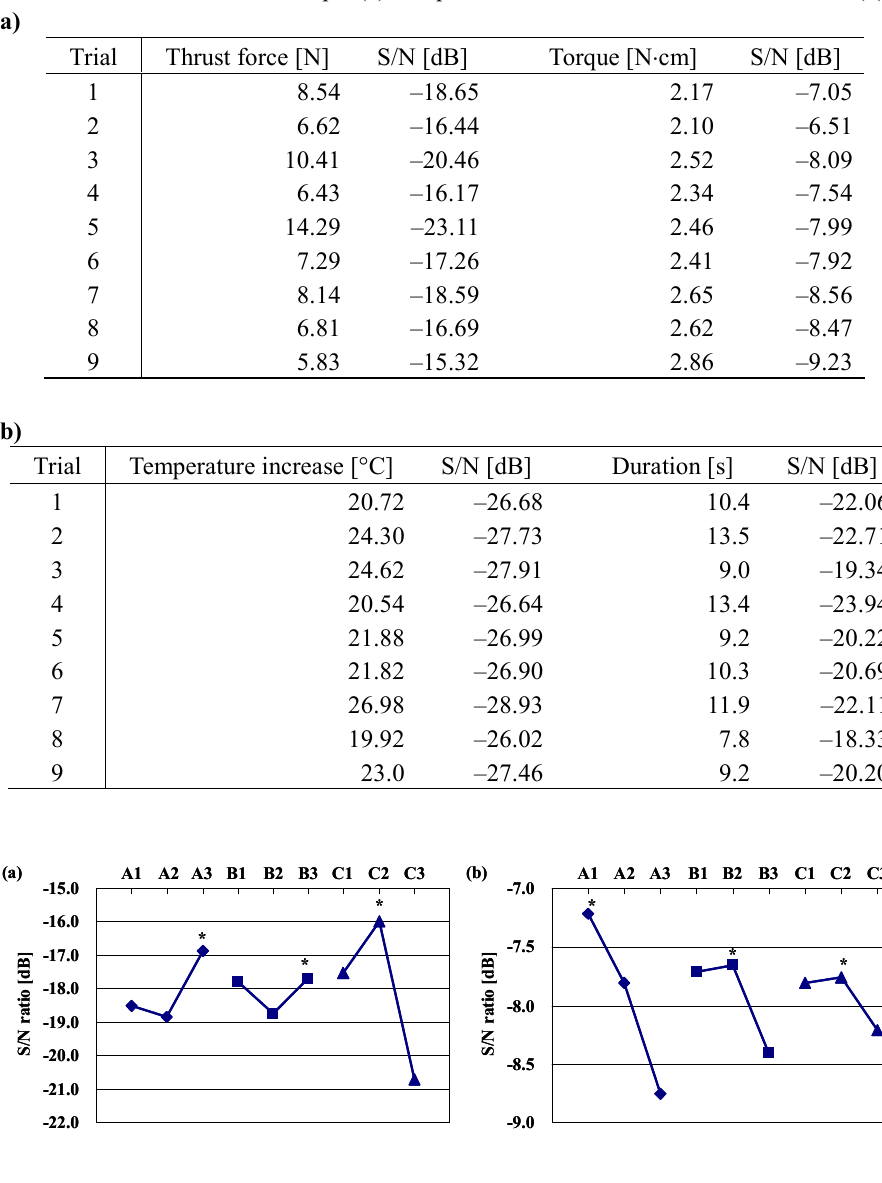
Table 3 Thrust force, torque (a), temperature increase, duration, and S/N ratio (b)